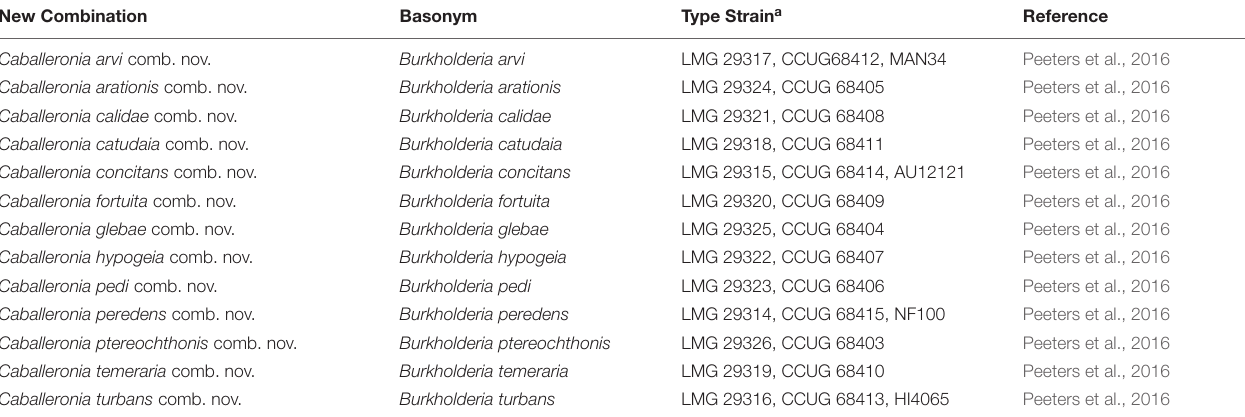
TABLE 3 | Summary of the novel combinations proposed for 13 species of